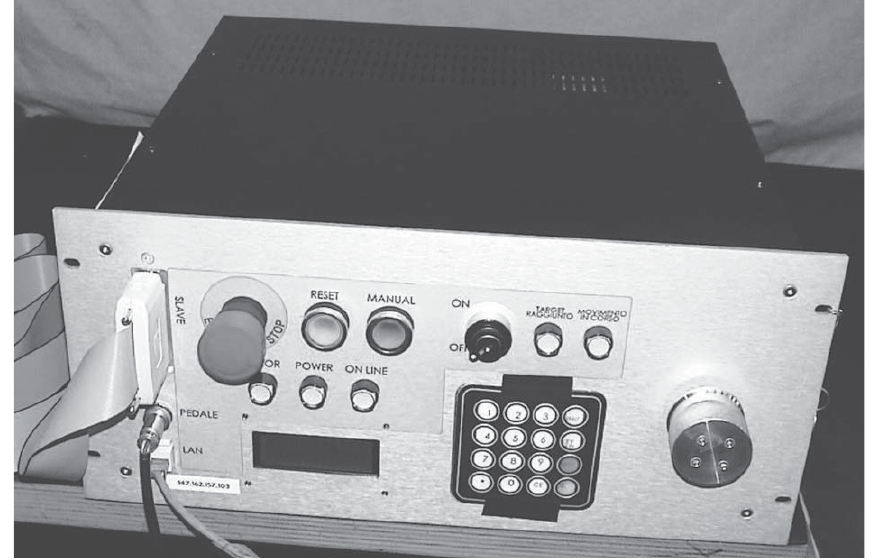
Fig. 12. Master unit of the